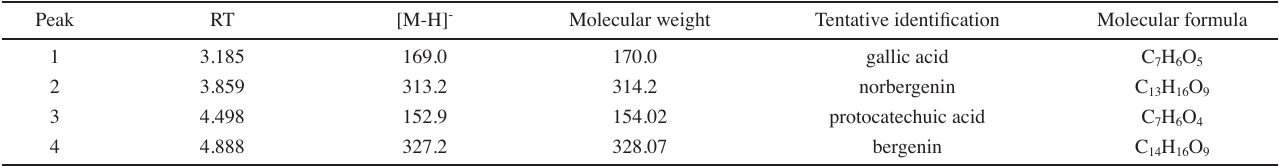
Fig. 1: Chromatography profile (275 nm) (A), the total ion chromatography (TIC) (B) and mass spectrometry (C) of S. stolonifera by HPLC- DAD-MS/ES ¯ . In Fig. 1 A, peak 1, 2, 3 and 4 respresent four components in S. stolonifera . MS/ES ¯ spectra (a, b, c and d) of the four components in S. stolonifera are corresponding to 1, 2, 3 and 4 in Fig. 1 A and B, Tab. 1: MS/MS analysis of methanol extract of S. stolonifera .